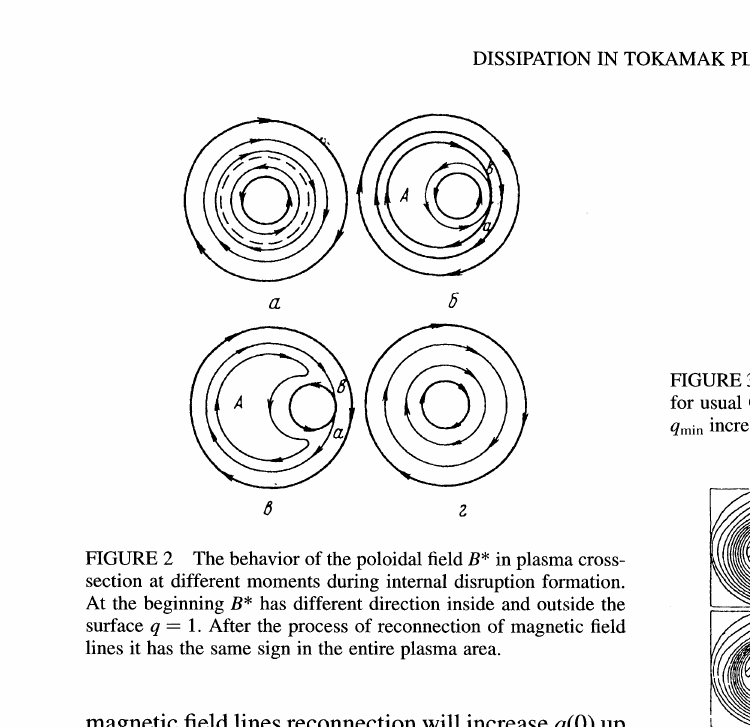
FIGURE 2 The behavior of the poloidal field B* in plasma cross- section at different moments during internal disruption formation. At the beginning B* has different direction inside and outside the surface q